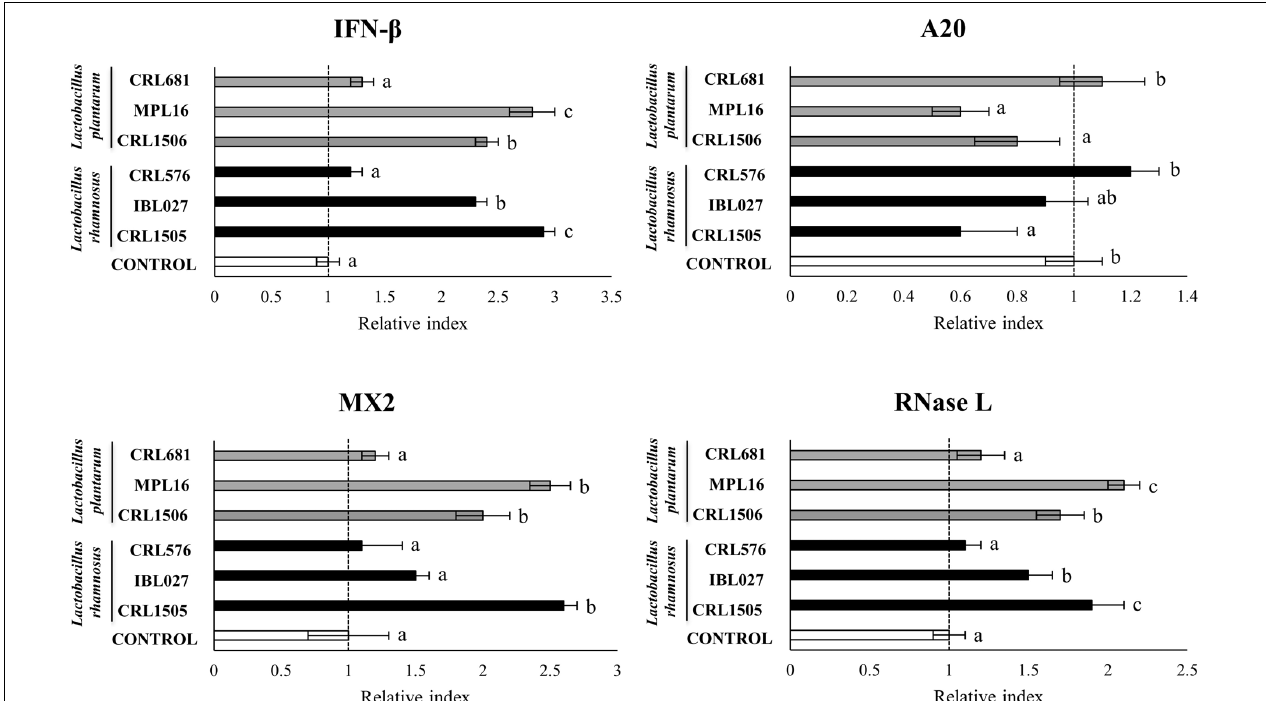
FIGURE 1 | Expression of interferon ( IFN ) - β , antiviral factors ( MX2 and RNASEL ), and the negative regulator A20 genes in porcine intestinal epithelial (PIE) cells treated with Lactobacillus rhamnosus CRL1505, L. rhamnosus IBL027, L. rhamnosus CRL576, Lactobacillus plantarum CRL1506, L. plantarum MPL16, or L. plantarum CRL681 and challenged with the viral molecular–associated pattern poly(I:C), analyzed by quantitative polymerase chain reaction. Porcine intestinal epithelial cells with no lactobacilli treatment and stimulated with poly(I:C) were used as controls. The results represent data from three independent experiments. Letters indicate significant differences ( P < 0.05), a < b <